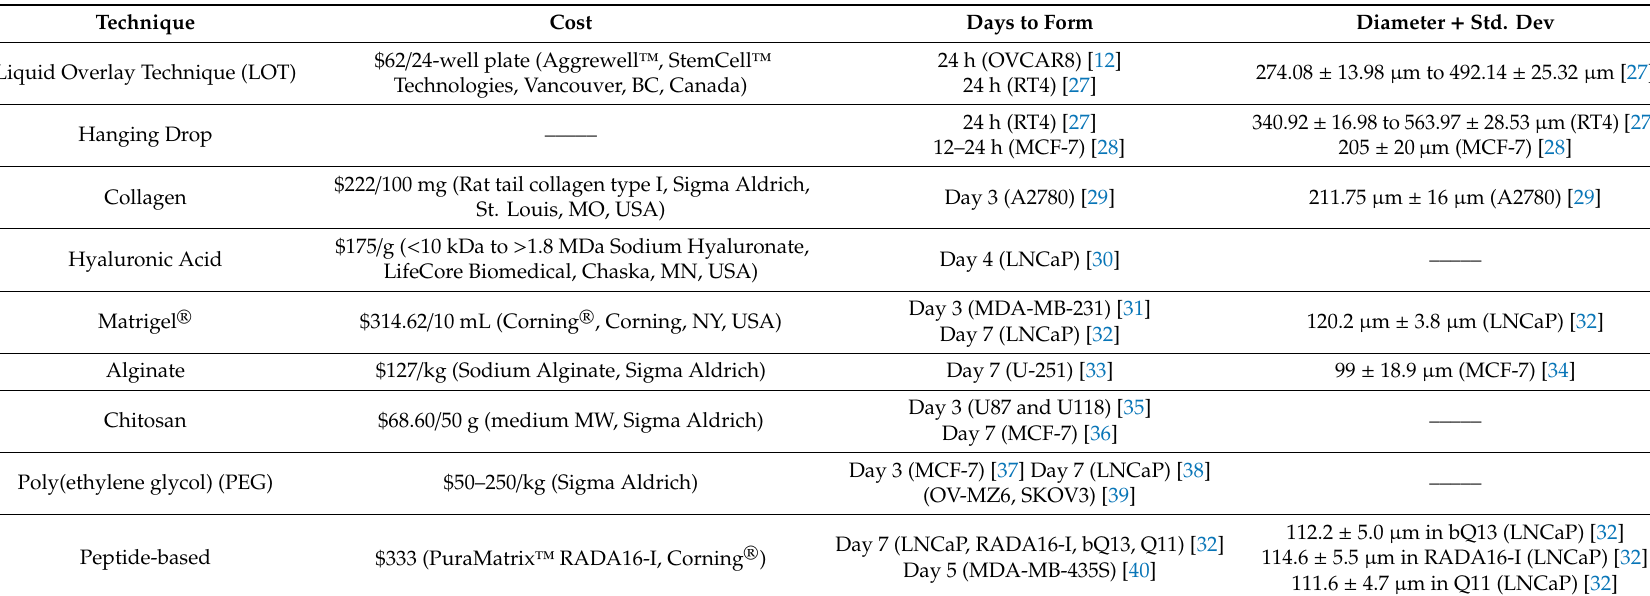
Table 1. Cost, formation timeline and uniformity of matrix-independent and matrix-dependent